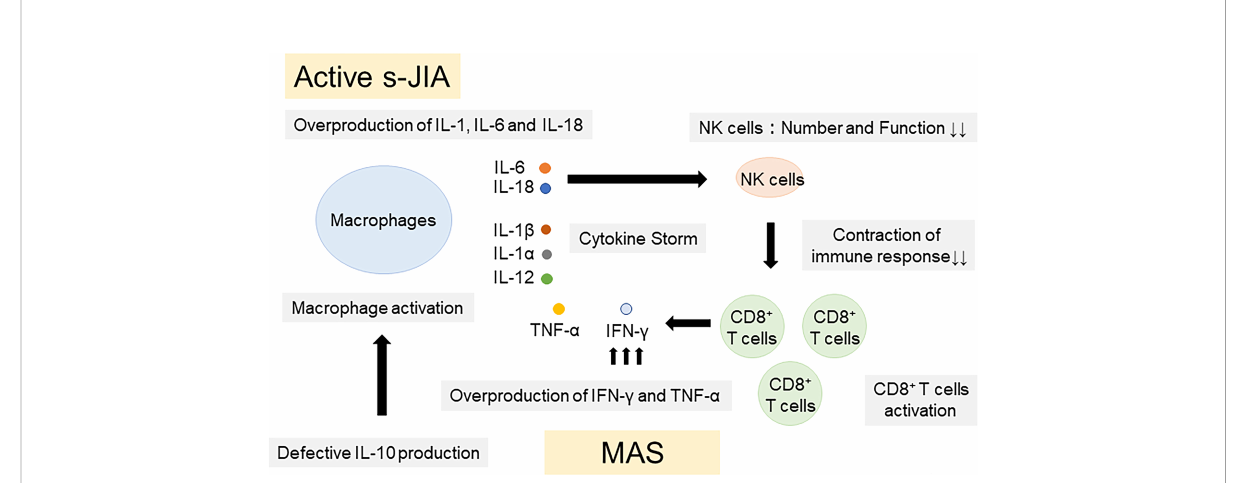
FIGURE 2 Pathogenic mechanisms of IL-18 in the pathogenesis of s-JIA and MAS. Overproduction of IL-1, IL-6 and IL-18 is a hallmark of active phase of s-JIA. In vivo exposure highly elevated IL-6 and IL-18 levels and induced NK cell dysfunction and decreased the number of cells. Defective NK cells are unable to contract immune responses, leading to massive expansion and activation of CD8+ T cells and overproduction of IFN- g and TNF- a . Furthermore, inadequate production of IL-10, a regulatory cytokine to counter-regulate IFN- g , might be related to the development of MAS. IL, Interleukin; TNF, tumor necrosis factor; IFN, Interferon; CD, cluster of differentiation; NK, natural killer; s-JIA, systemic juvenile idiopathic arthritis; MAS, macrophage activation